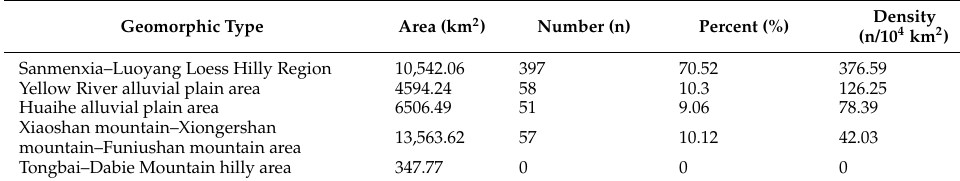
Table 4. Relationship table of settlement distribution and landform